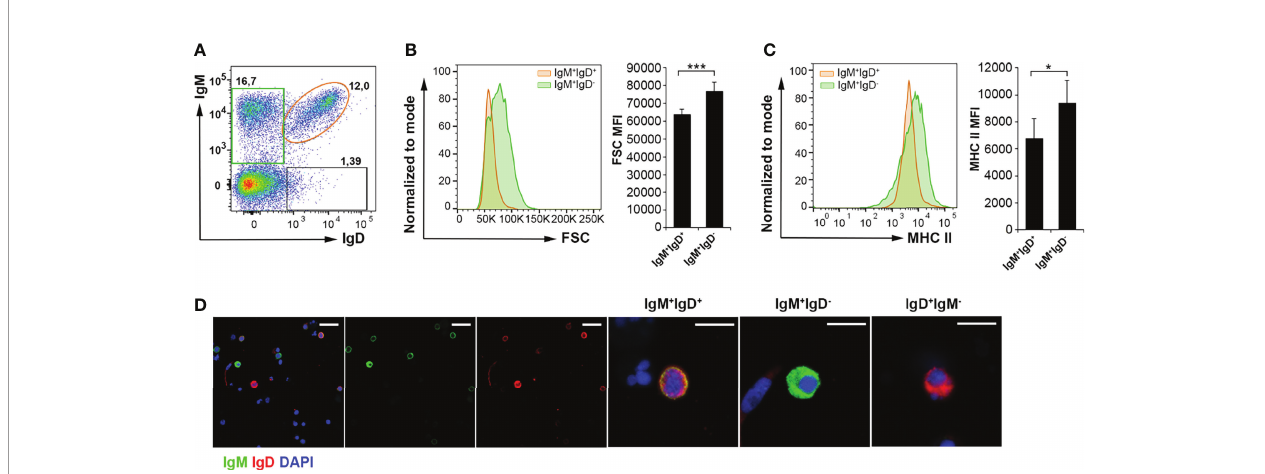
FIGURE 3 | Characterization of IgM + B cells subpopulations in rainbow trout AT by fl ow cytometry and confocal microscopy analysis. Rainbow trout AT leukocytes were labeled with anti-IgM, anti-IgD and anti-MHC-II trout mAbs. (A) Representative dot plot showing IgM and IgD pro fi les in AT samples is shown to de fi ne the different gated B cell subsets. (B) Histogram showing FSC values of IgM + IgD + B cells (orange) compared to IgM + IgD - B cells (green), from one representative fi sh, along with the corresponding graph showing the MFI values for FSC (mean + SD; n = 8 fi sh). Asterisks denote signi fi cantly different values between indicated groups (***p ≤ 0.005). (C) Histogram showing MHC II expression levels on the surface of IgM + IgD + B cells (orange) compared to that of IgM + IgD - B cells (green) in one representative fi sh is shown, along with the corresponding graph showing the MFI values for MHC II (mean + SD; n = 8 fi sh). Asterisks denote signi fi cantly different values between the indicated groups (*p ≤ 0.05). (D) Isolated AT leukocytes were labeled with anti-IgM (green) and anti-IgD (red) and counterstained with DAPI (blue) and the different subpopulations of AT B cells (IgM + IgD + ; IgM + IgD - and IgD + IgM - ) visualized by confocal microscopy. Examples of each B cell subset are shown in higher magni fi cation images. Scale bars in left-hand images: 20 m m; scale bars in right-hand images: 5 m